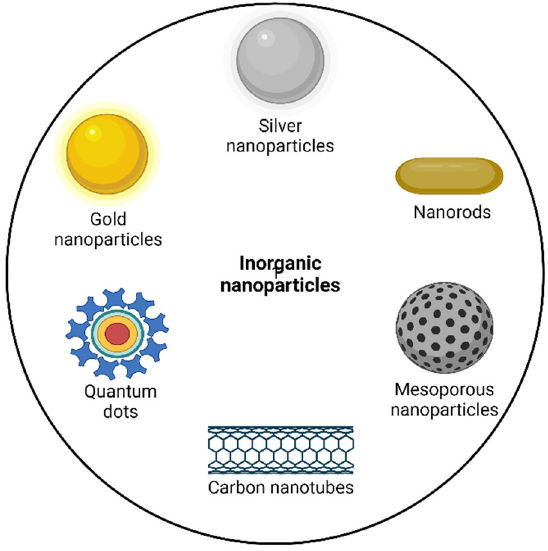
Figure 2. Important types of inorganic